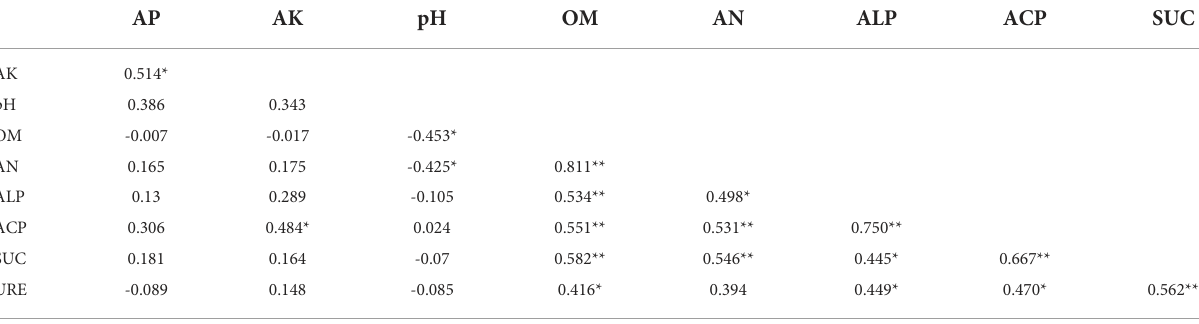
TABLE 3 Pearson correlations between soil chemical and biological